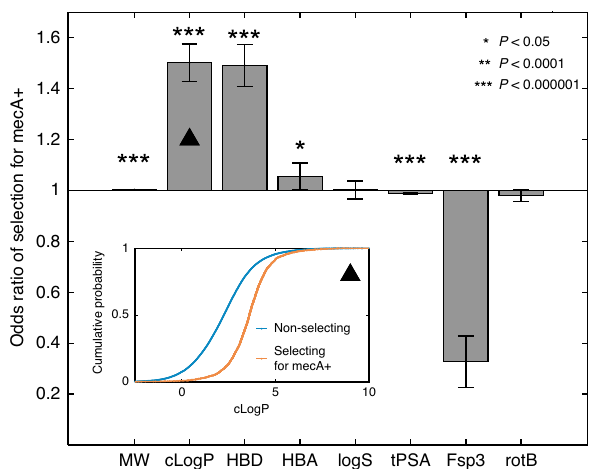
Fig. 5 Enhanced selection in favour of mecA by compounds with speci fi c physicochemical properties. Multivariable logistic regression model for the association of strong selection in favour of the mecA + strain (Single-Dose assay) with compounds ’ physicochemical properties (selecting for mecA + compounds n = 2592, non-selecting compounds n = 44,647). Error bars are 95% con fi dence intervals; asterisks indicate statistical signi fi cance (HBA, P = 0.03; MW, cLogP, HBD, tPSA and Fsp3, P < 10 − 10 ). Inset panel is the cumulative probability of cLogP for non-selecting and selecting for the mecA + strain compounds. Source data are provided as a Source Data fi